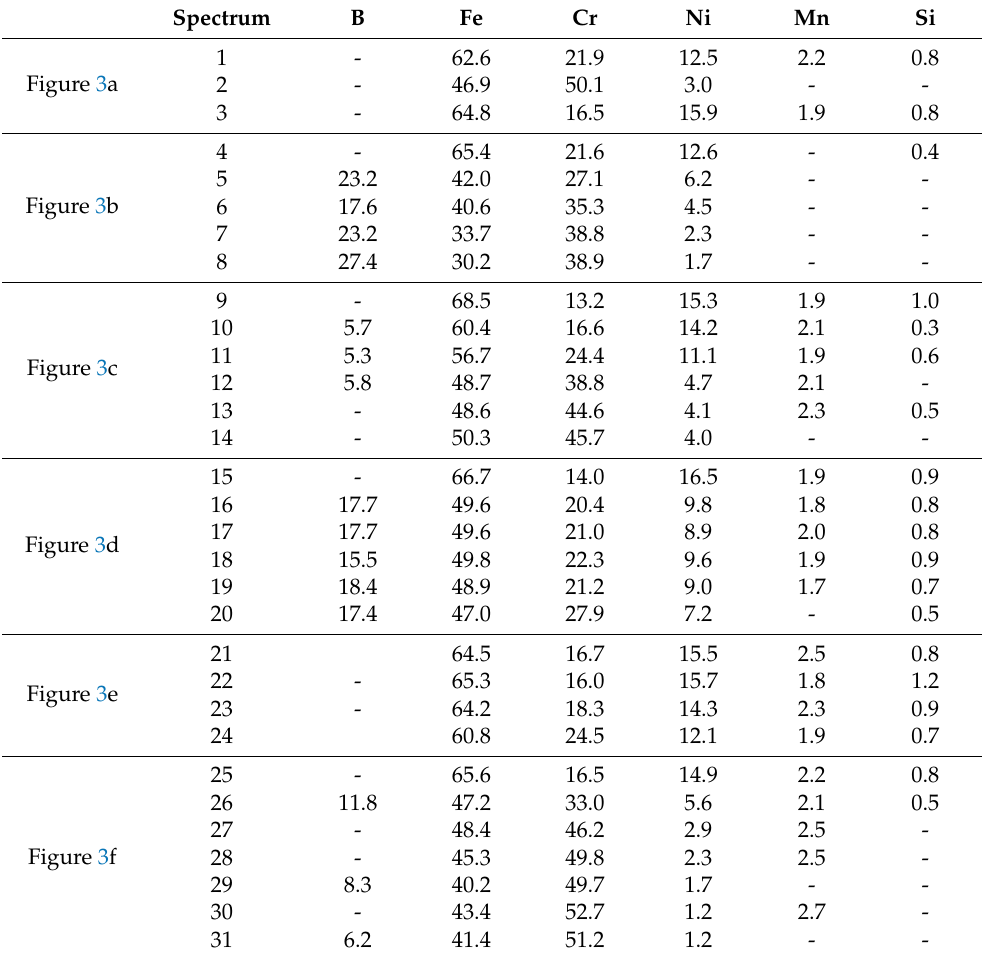
Table 2. Elements content of SEM-EDS point scan analysis of